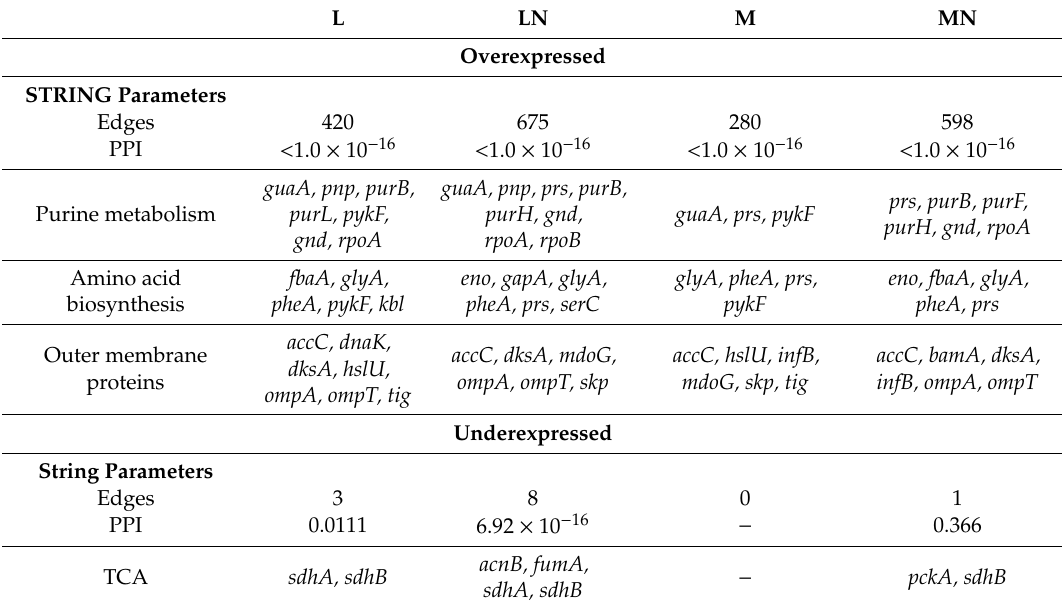
Table 2. E. coli genes / proteins, metabolic pathways and cell components a ff ected by chitosan exposure and identified by STRING. The genes encoding di ff erentially expressed proteins were listed for each CS-polymer / nanoparticle, see Supplementary Table S1B for detailed